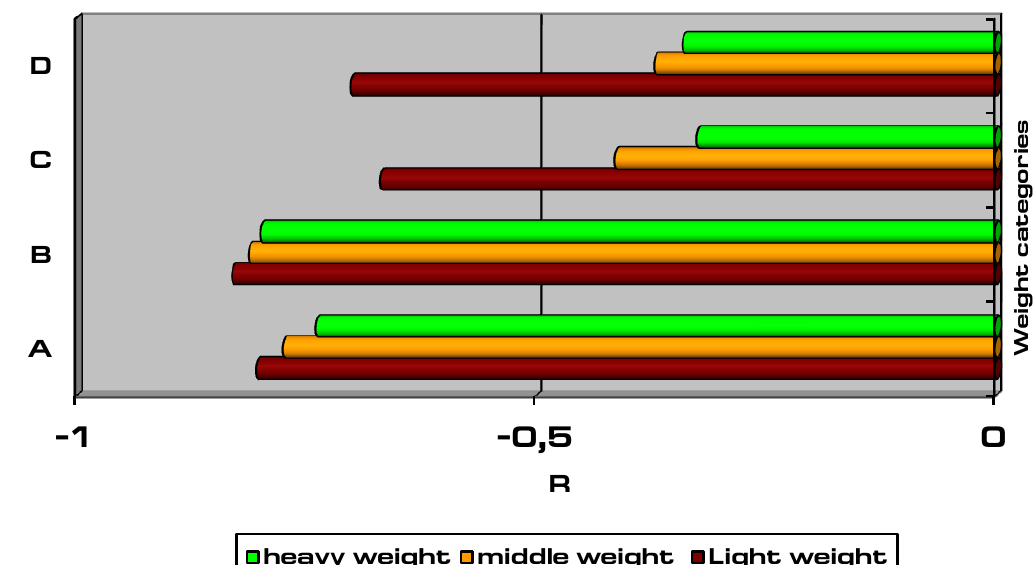
Fig.1. Results of pair correlation’s analysis between physical preparedness and qualification of martial arts’ sportsmen, specializing in combat